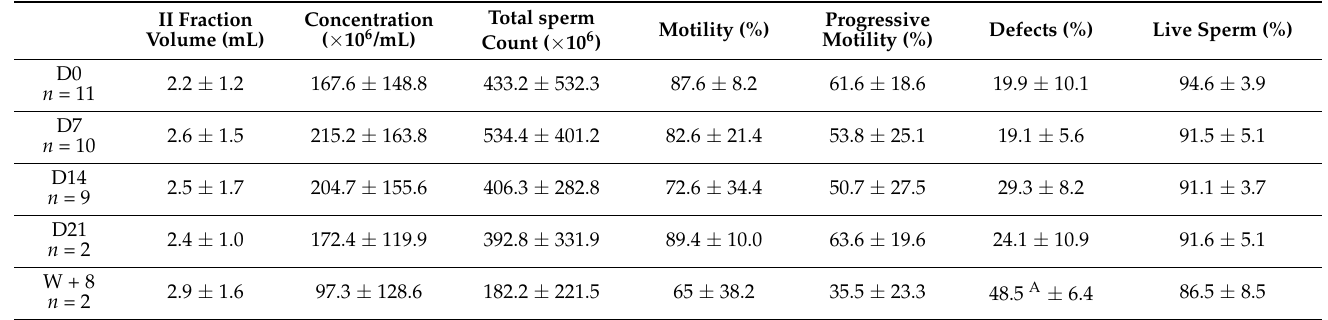
Table 3. Values of qualitative and quantitative parameters of the sperm II fraction samples collected from dogs in Group III (BPH treated with Deslorelin Acetate—SUPRELORIN ® VIRBAC ® ) compared to the study on day 0 ( n = 11). Results presented as mean ± SD ( A p < 0.05)